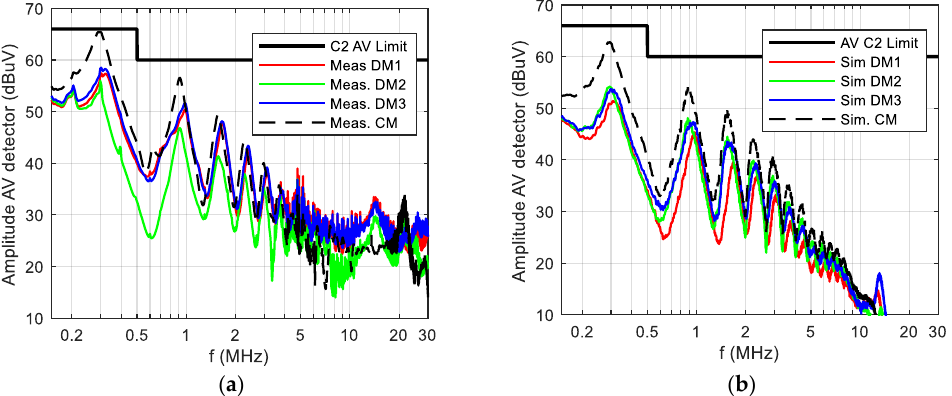
Figure 5. Average detector noise level of differential mode and common mode noise emissions as defined in Equation (1) with a 100 m motor cable (16 mm 2 ) ( a ) Measurement with CM/DM LISN separator. ( b ) Simulation results.